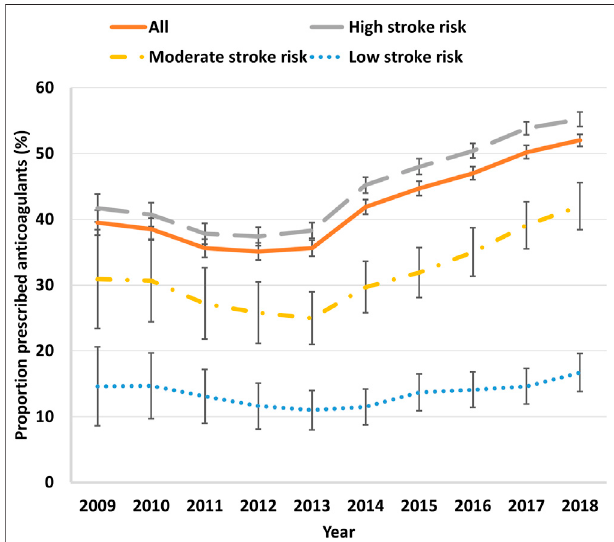
FIGURE1| TrendsoforalanticoagulantprescribinginAustraliangeneral practice patients with atrial fi brillation strati fi ed by CHA2DS2-VASc score, 2009 – 2018. Error bars indicate 95% con fi dence intervals.